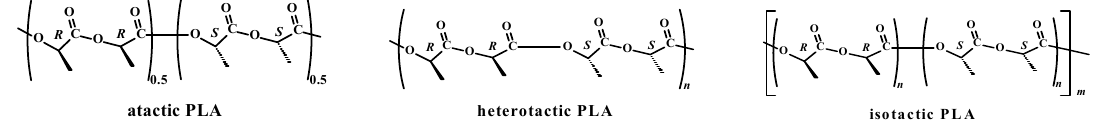
Figure 5. 13 C-NMR spectra of atactic PLA (methine region) ( PLA 6 ).